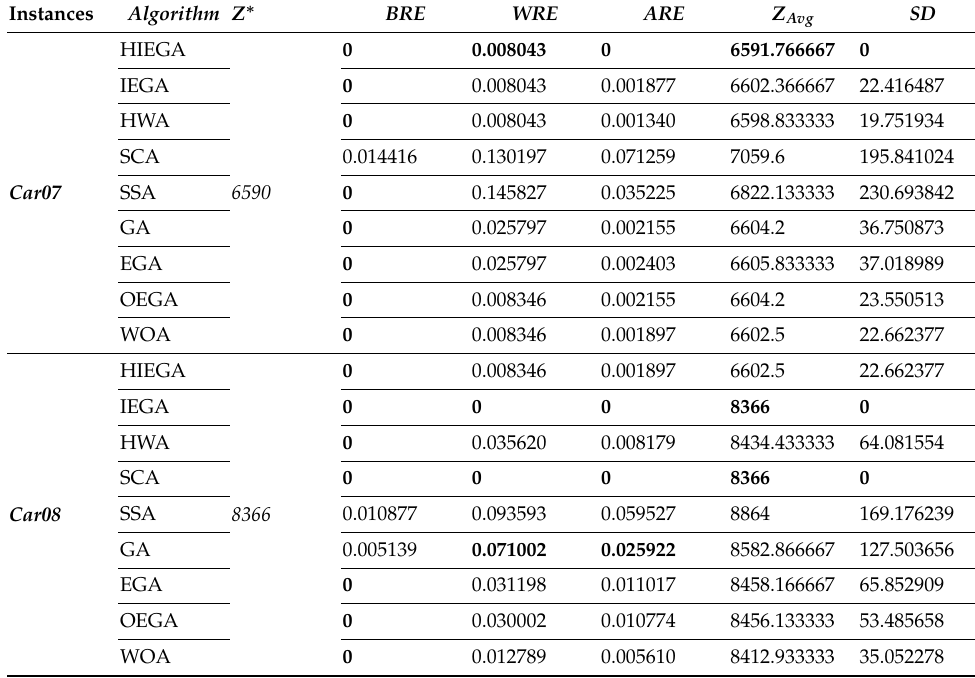
Table 4. Outcomes of different performance metrics on the Car instances (Car07–Car08).